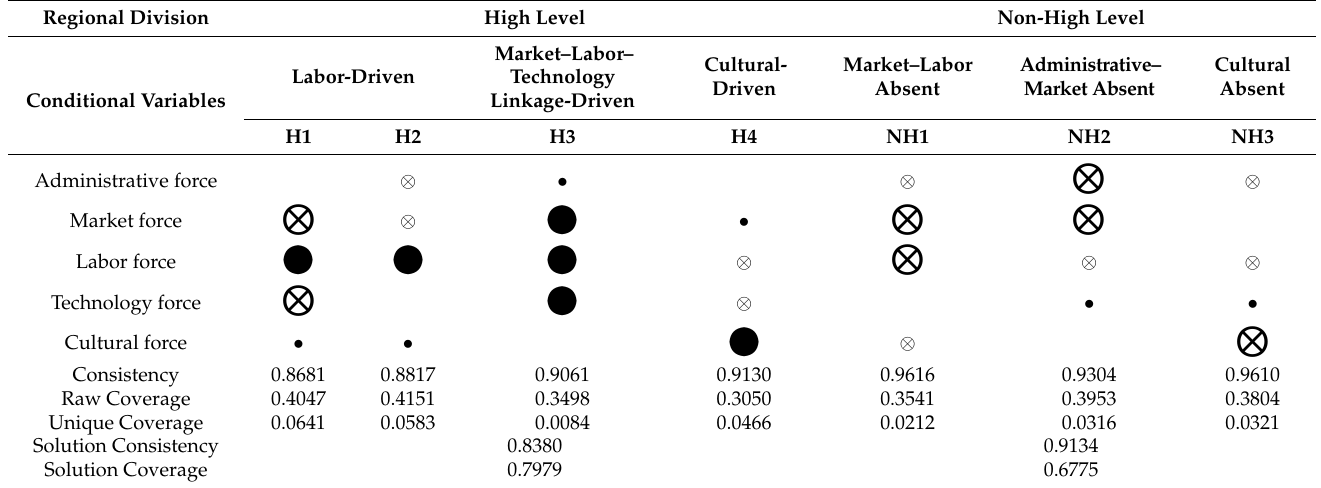
Table 8. Analysis of high-level and non-high-level rural resilience configuration.